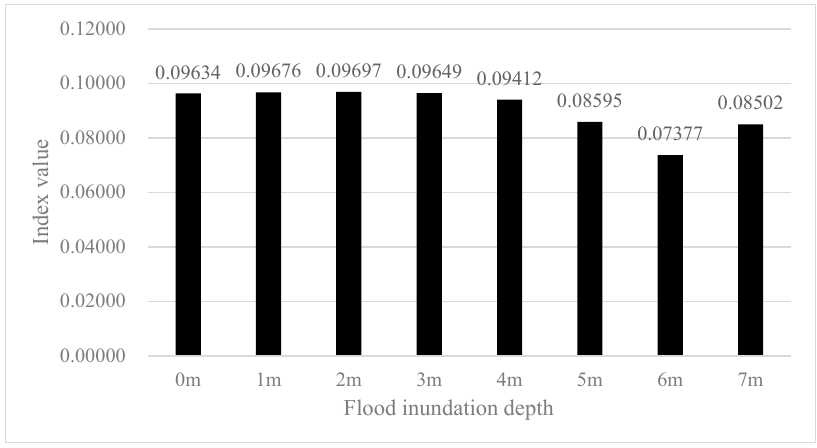
Figure 8. Analysis results of the road network efficiency for the study area (Source: self-drawn by the author).